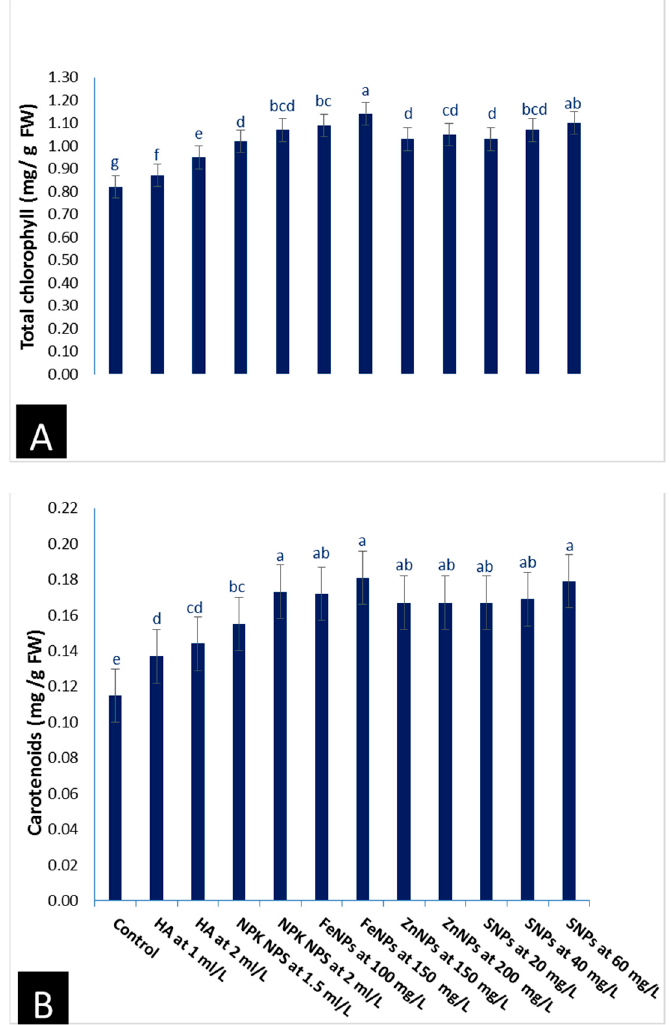
Figure 1. Effect of nanoparticles and humic acid on total chlorophyll ( A ) and carotenoid ( B ) (mg/g FW) content in Philodendron bipinnatifidum during 2019/2020 and 2020/2021 seasons. The same letters show no significant differences between the treatments according to ANOVA, Duncan’s multiple range test at 0.05 level. Data are the mean of both seasons (±SE) of three replicates.